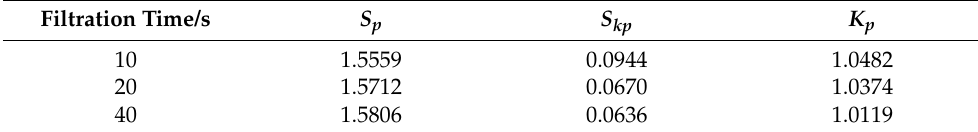
Table 3. Characteristic parameters of the pore size distribution at the different filtration times. Filtration